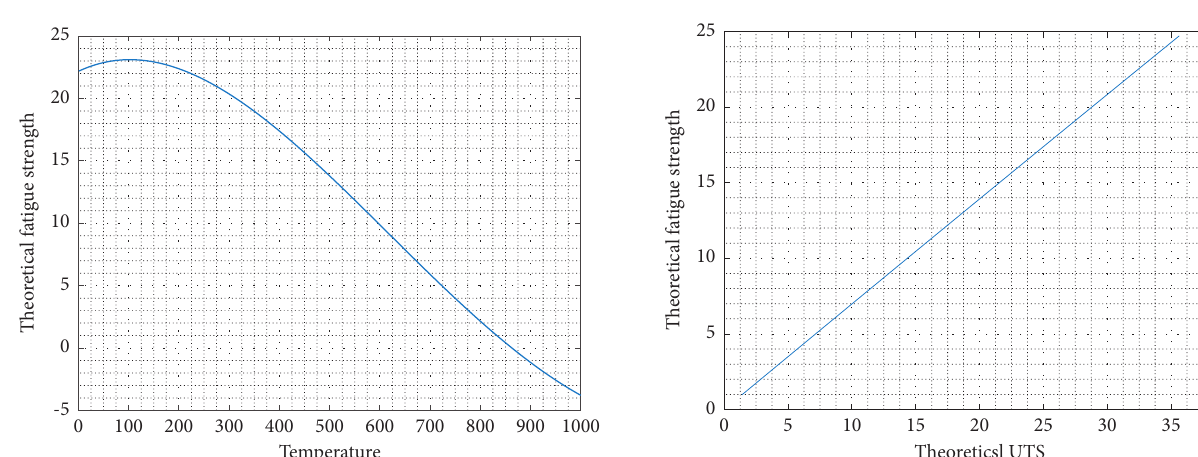
Figure 8: Theoretical fatigue strength v/s temperature for similar materials.